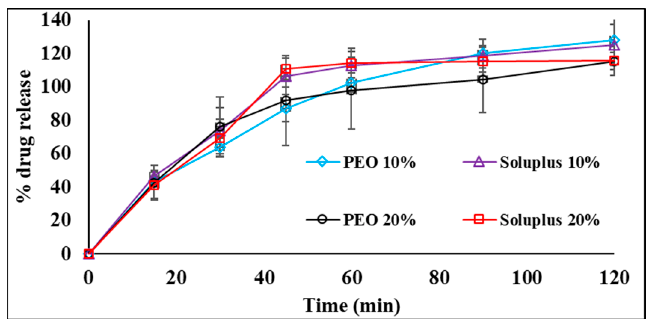
Figure 2. Drug release profiles of triamcinolone acetonide from 10% and 20% w / w PEO and Soluplus® films (mean ± SD, n = 3). *,# indicates that the permeability and flux of PEO TA-films were statistically significant when compared to control at p < 0.05.